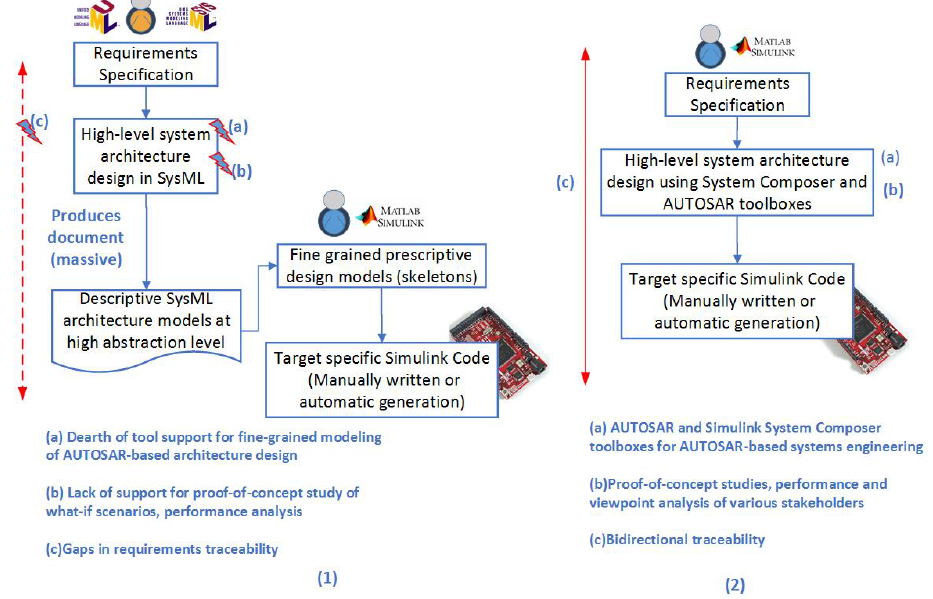
Figure 1. Steps for AUTOSAR-based architecture modeling of automotive embedded